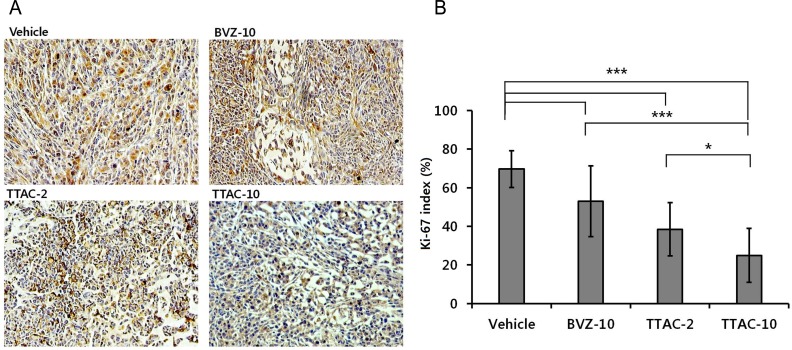
Immunohistochemistry with the anti-Ki-67 antibody to detect proliferation.(A) Microscope images (magnification × 400) of the four groups (control, BVZ-10, TTAC-2, TTAC-10). (B) The Ki-67-positive cells in tumors are shown for each group. Data are presented as mean ± sd in the graphs. ***, P < 0.001; **, P < 0.01; *, P < 0.05. BVZ-10, bevacizumab 10 mg/kg; TTAC-2, TTAC-0001 2 mg/kg; TTAC-10, TTAC-0001 10 mg/kg.